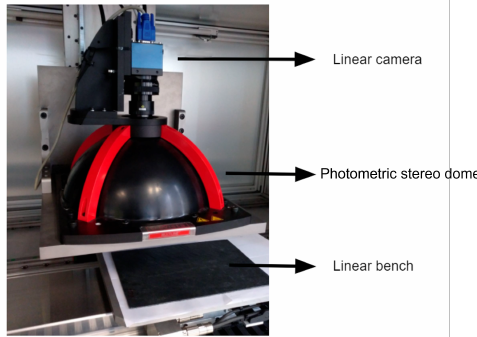
Figure 6. Acquisition set up to capture photometric stereo